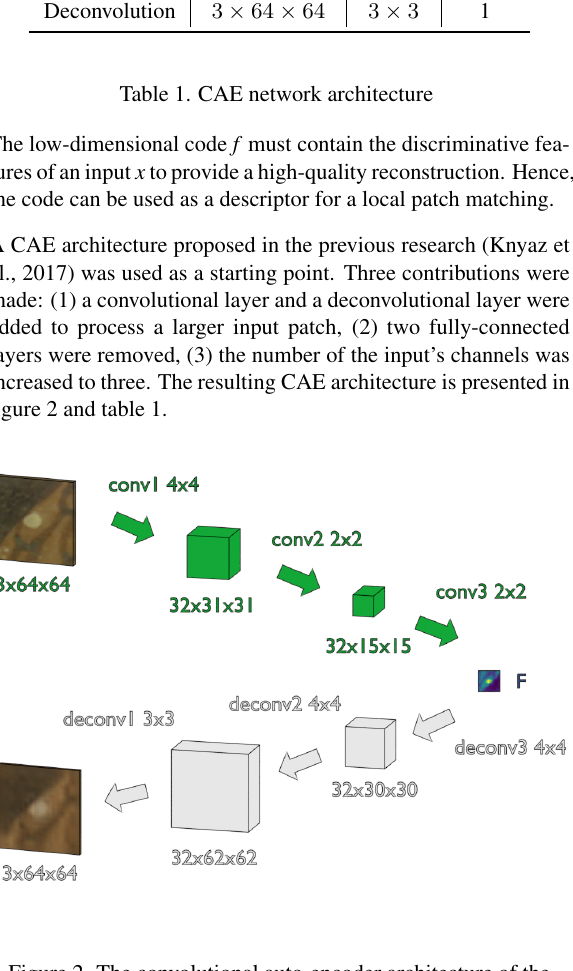
Figure 2. The convolutional auto-encoder architecture of the WIZARD descriptor